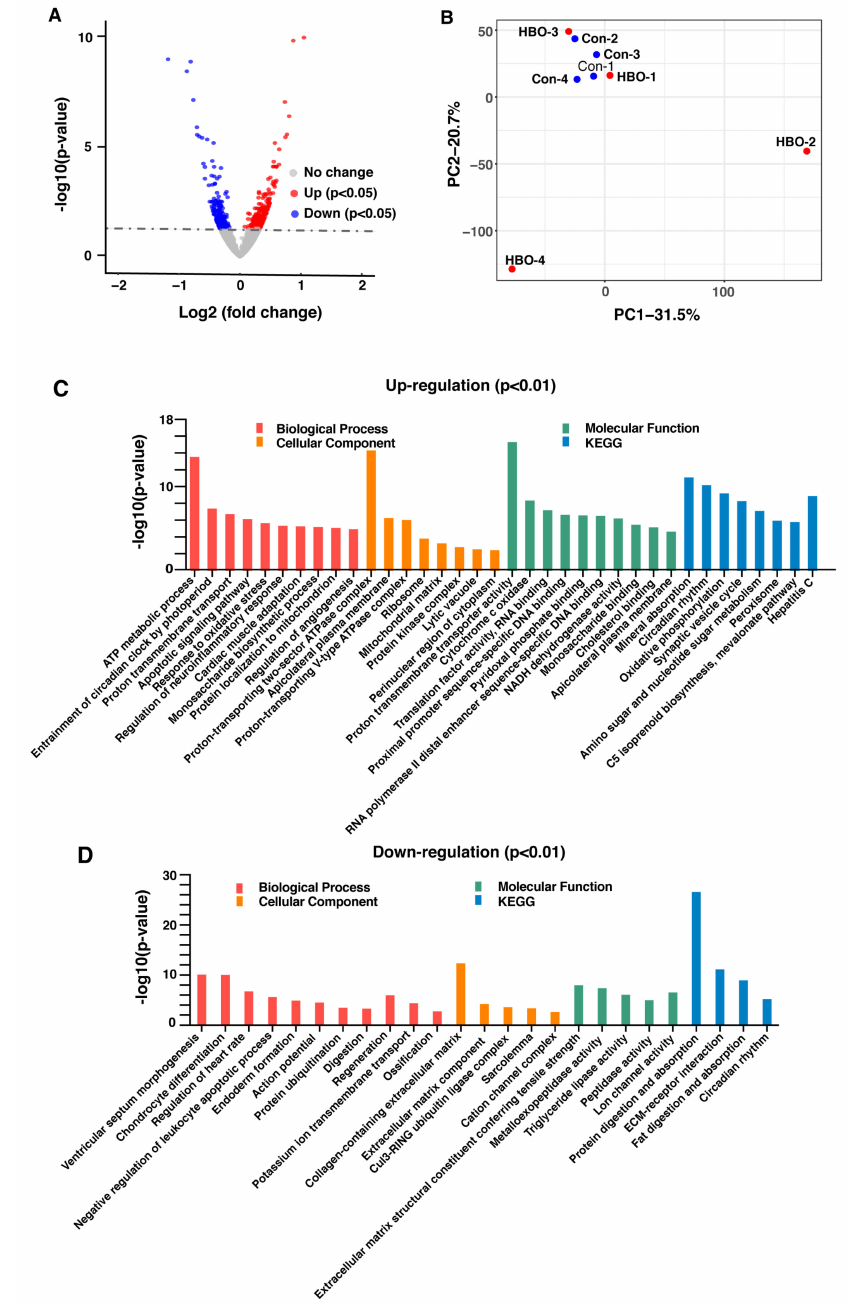
Figure 2. Repetitive HBO exposure had a small influence on the gene expression of lung tissues. ( A ) Volcano plot of genes using DEseq2, showing the di ff erences in expression values between the control and HBO group. Grey dotted line indicates the threshold for p -value = 0.05. Blue and red points represented down-regulated and up-regulated di ff erentially expressed genes respectively. ( B ) Principal componentsanalysis (PCA)oftranscriptomic datafromeachsample. The firsttwoprincipal components were shown in the plot and represented 31.5% of the variation (PC1) and 20.7% of the variation (PC2). ( C ) and ( D ) GO and KEGG enrichment analysis of up-regulated ( C ) and down-regulated di ff erentially expressed genes ( p < 0.01). Biological processes are indicated in red, orange indicates cellular component, green shows molecular function and blue bar shows KEGG